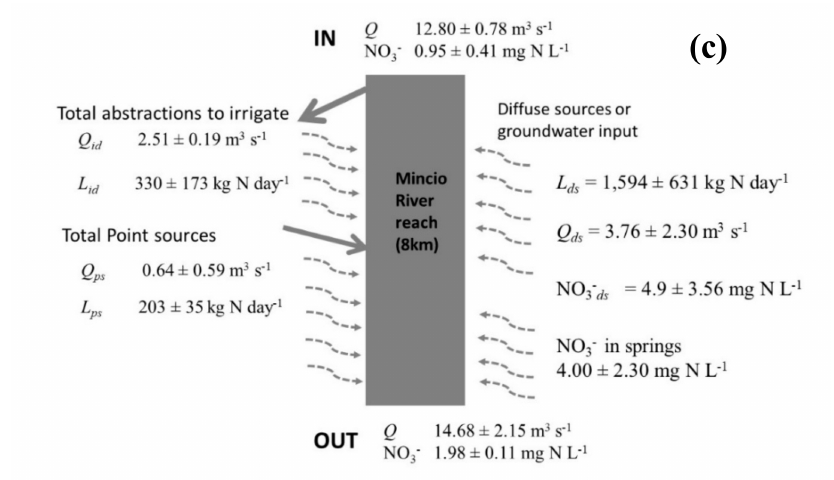
Figure 6. Nitrate and water budgets for the three reaches of Adda, Oglio, and Mincio rivers crossing the spring belt. Summer N budget were performed for the 18 km long Adda River reach ( a ), the 19 km long Oglio River reach ( b ), and the 8 km long Mincio river reach ( c ). River discharge ( Q ) and the nitrate concentration (NO 3 − –N) are reported for the reach extremes (IN and OUT), while the discharge ( Q ) and the N load ( L ) are indicated for irrigation abstractions ( id ), point sources ( ps ), and di ff use sources ( ds ). From the nitrate and the water budgets, it was possible to estimate the NO 3 − concentrations of the di ff use inputs (NO 3 − ds ), which were compared to the NO 3 − concentrations in spring water from the measured